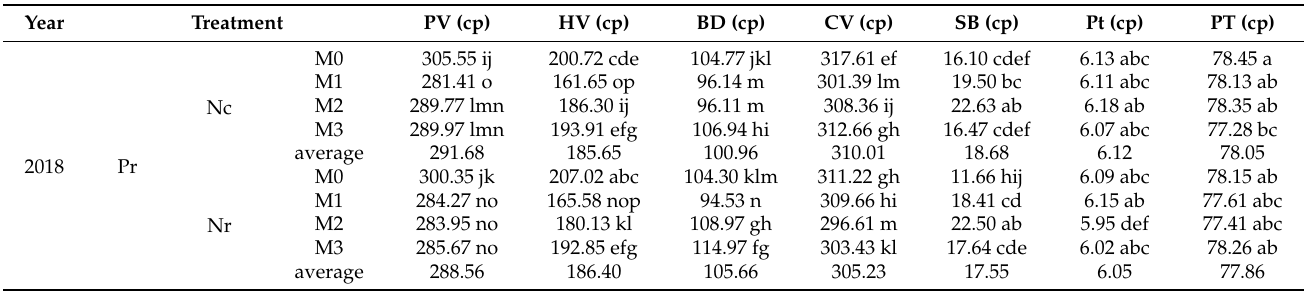
Table 5. The effects of the N application rate in the previous season and N management in the rice season on the RVA profile characteristic value of